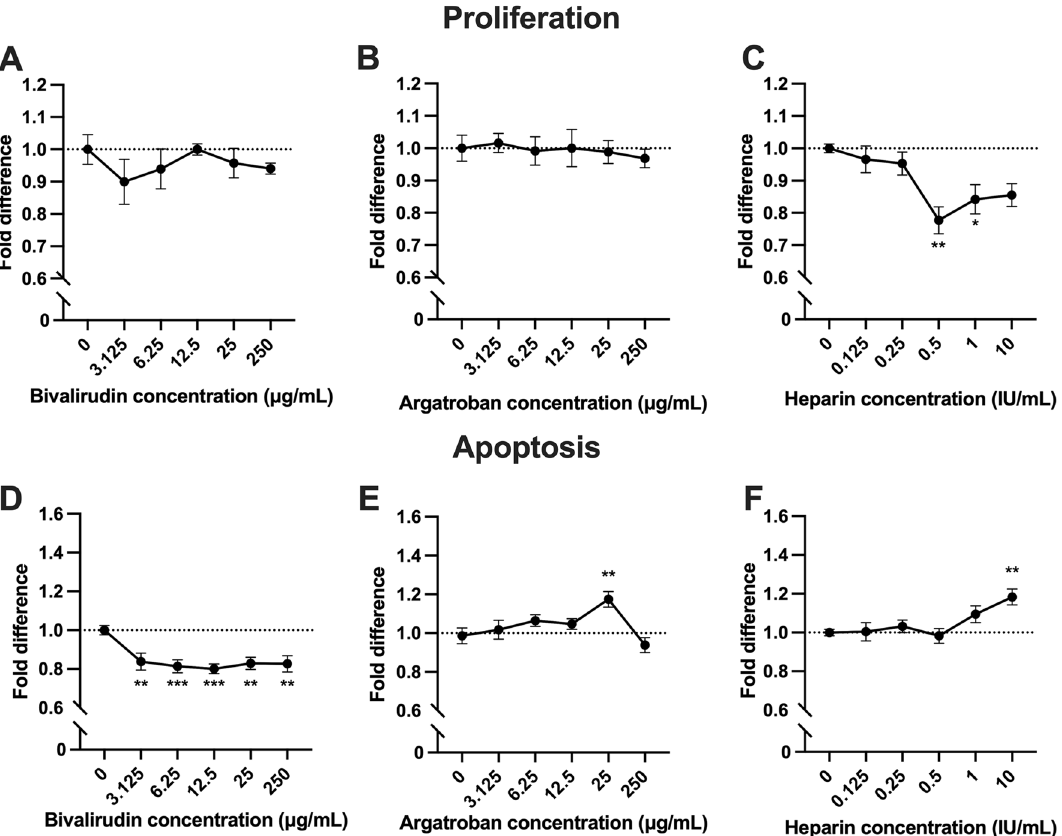
Figure 1. Lung endothelial cell proliferation and apoptosis. Bivalirudin ( A ) and argatroban ( B ) did not affect human lung microvascular endothelial cell (HMVEC-L)-L proliferation at various dosages. Heparin, however, inhibited proliferation of HMVEC-L cells in a dose-dependent manner ( C ). Bivalirudin consistently inhibited apoptosis ( D ). Argatroban increased apoptosis at a single dose (25 μg/mL) while remaining doses of argatroban did not impact apoptosis ( E ). Increasing doses of heparin increased HMVEC-L apoptosis ( F ). Each anticoagulant dose was performed in technical quadruplicate and the experiments were repeated up to 3 times. Comparisons were done using a one-way analysis of variance (ANOVA) with Dunnett’s adjustment for multiple comparisons. Shown are mean ± standard error. *P < 0.05; ** P < 0.01; *** P <